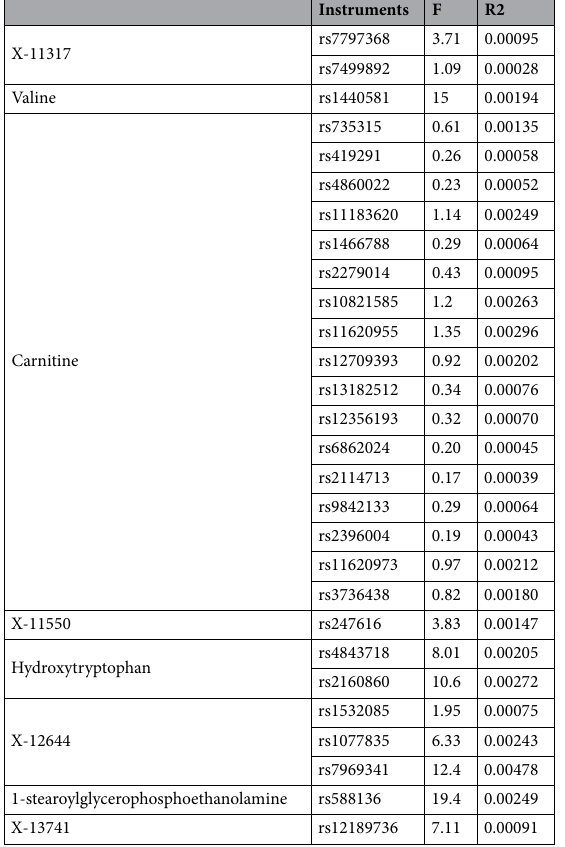
Table 3. The description of the